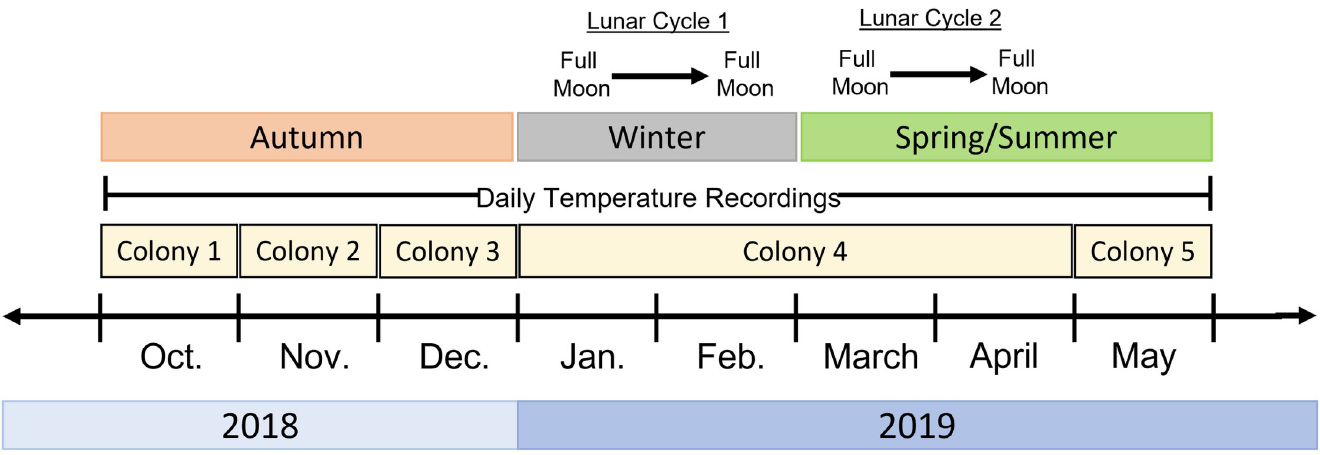
Fig 1. Timeline of data collection by month. We recorded nocturnal activity from 5 nights before to 5 nights after the full moon of every month except October and November, where we recorded nocturnal activity from the full moon to 5 nights after the full moon due to delays in obtaining A . dorsata colonies. The colony observed each month is shown, as is the season to which each month belongs. We obtained minimum temperatures for every observation day through an online resource (https://www.wunderground.com/history/daily/in/bangalore/VOBL). In addition to the observations focused on the full moon, we also observed Colony 4 for two complete lunar cycles, indicated by the text above; illumination readings were collected every observation night during the January to February lunar cycle (lunar cycle 1).